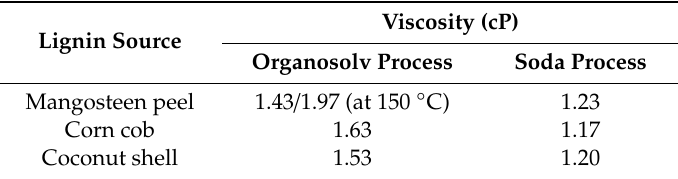
Table 2. Viscosity of